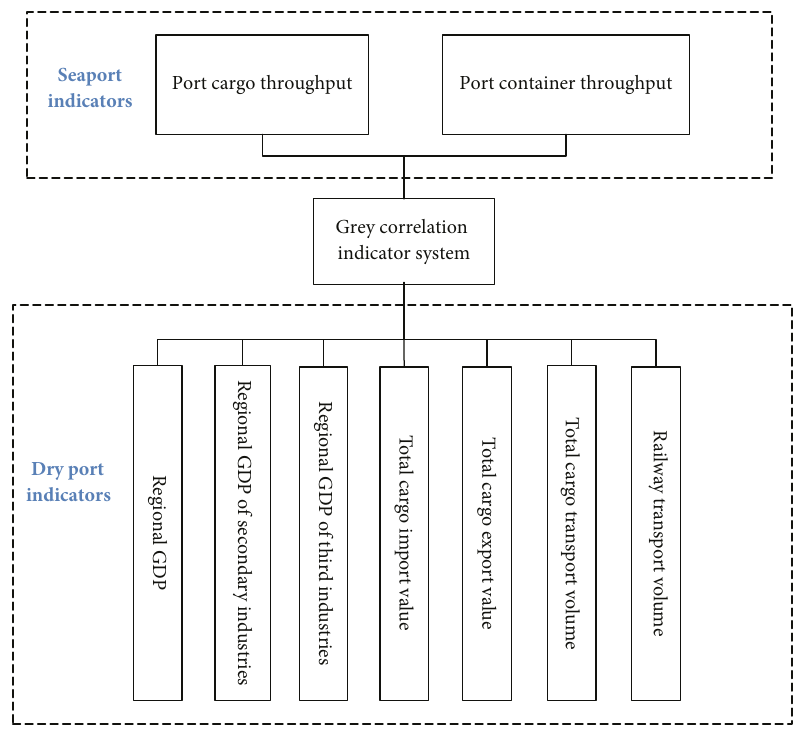
Figure 3: Assessment variables of seaports and their dry